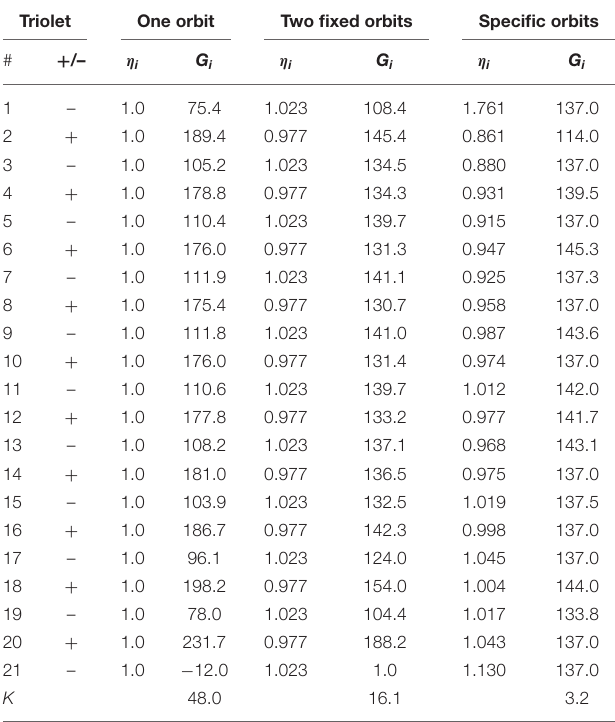
TABLE 1 | Stability and energy of various nucleus configurations.